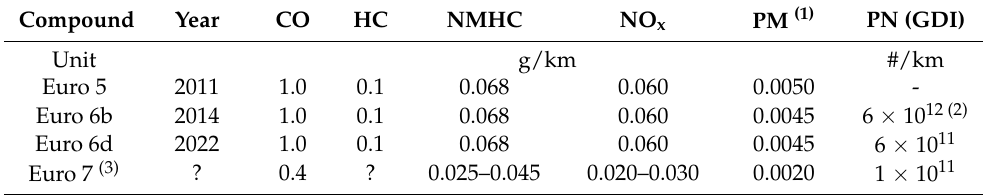
Table 1. Emission limits of the European Emission Standards for gasoline vehicles [9]. Compound